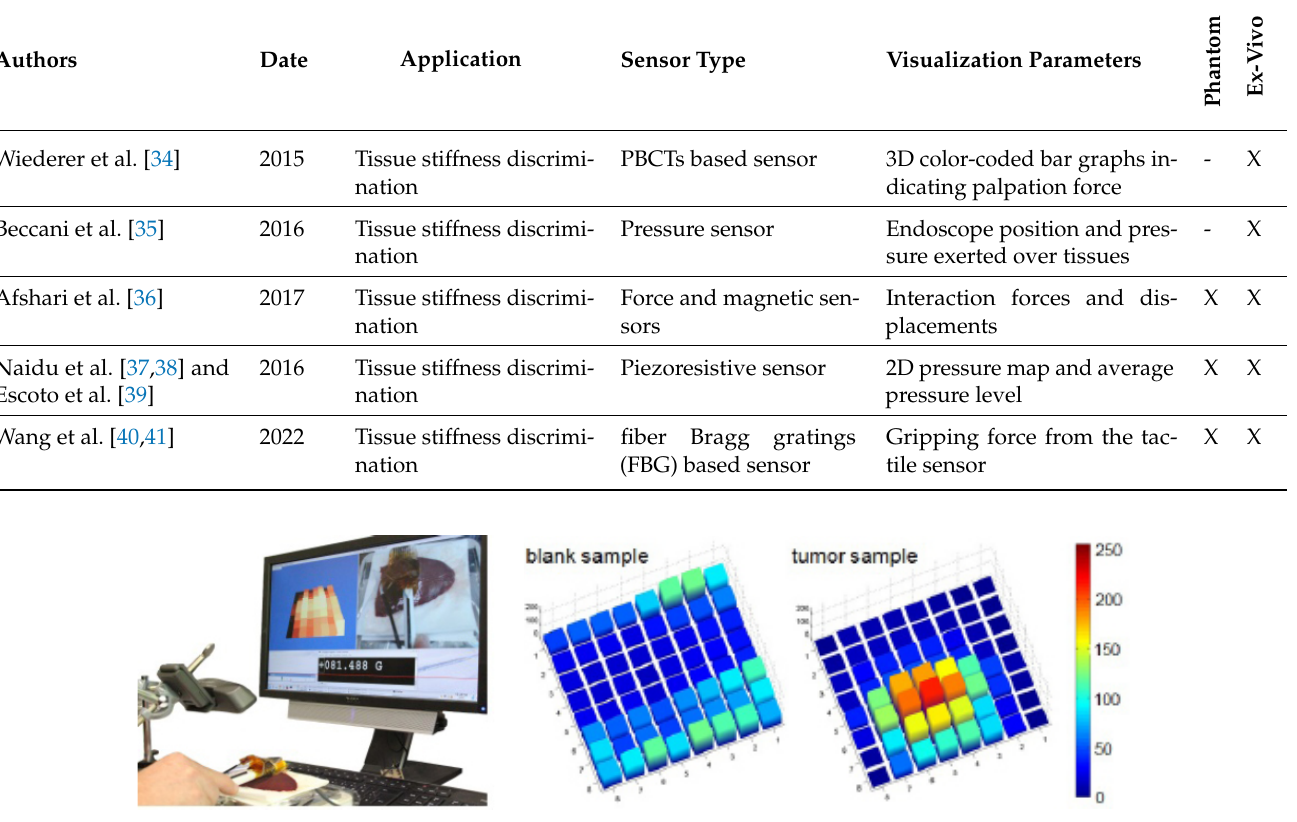
Figure 6. Pressure and force represented as a 3D color coded grid and bar graphs